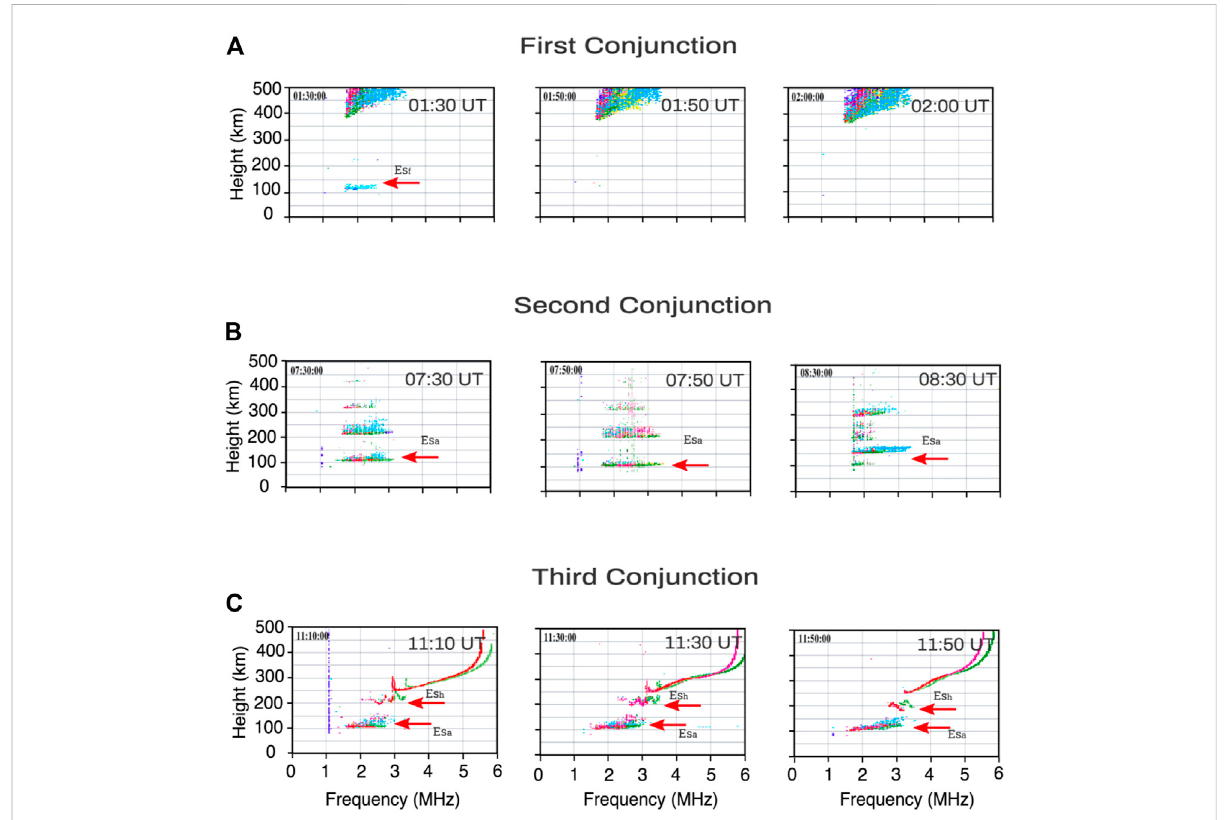
FIGURE 7 Ionograms from Digisonde located atCachoeira Paulista stationduring the fi rst (A) , second (B) and third (C) conjunctions. Thered arrows show the Es layers presence. The color code in these ionograms represents the echo direction of the signal received. Red shades denote O-polarization, and green shades indicate X-polarization. The blue points are used for the echoes in the North/East directions, and yellow shades are used for the South/West. More details can be found at